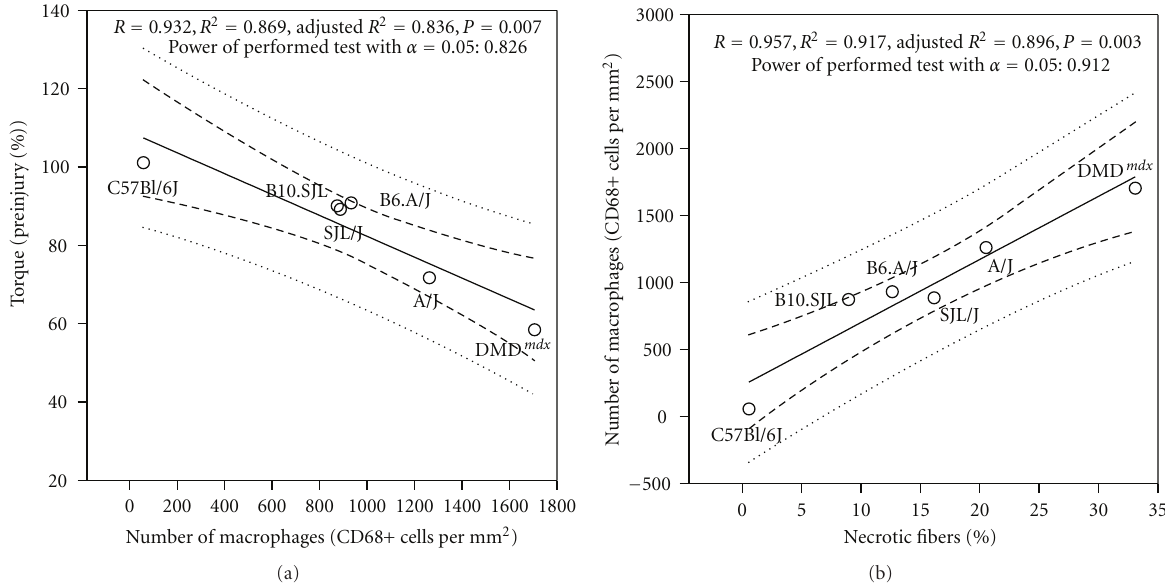
Figure 9: Regression analyses of contractile torque versus macrophage counts and macrophage counts versus necrosis. A regression analysis of the number of macrophages on D3 as the independent variable and torque at D3 as the dependent variable showed a good linear fit (a). Similarly, analysis of the number of necrotic fibers as the independent variable and the number of macrophages as the dependent variable also showed a good linear fit (b). The analyses suggest that that macrophage counts are a reliable negative predictor of functional recovery at D3 and that the number of necrotic fibers predicts the extent of macrophage